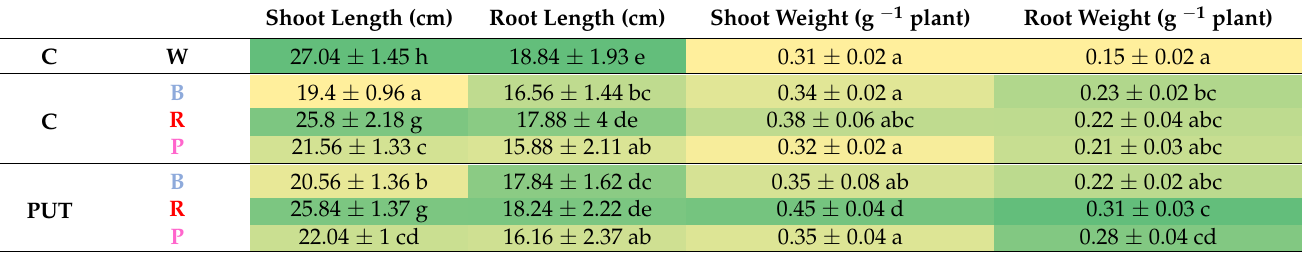
Table 2. Color-map comparison of biomass parameters of plants treated with or without polyamines (control: C, putrescine: PUT, spermidine: SPD and spermine: SPM) under different light regimes (white light: W, blue light: B, red + far-red: R and the combination of blue and red + far-red, pink: P). Values are means ± SD ( n = 30). Different letters indicate statistically significant differences at p < 0.05 level, using Duncan’s post hoc test.